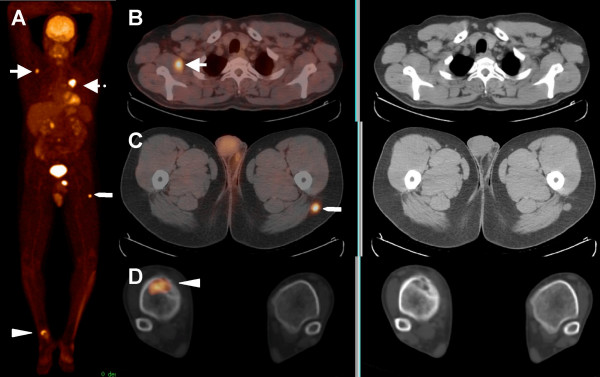
44-year-old male with history of non-small cell lung carcinoma. MIP image (A) and transaxial images (B, C and D) show the primary lesion in the left lung (dotted arrow), a single subcutaneous ST lesion in the left proximal thigh (pentagon) and a bone lesion in the right distal tibia (arrow head).